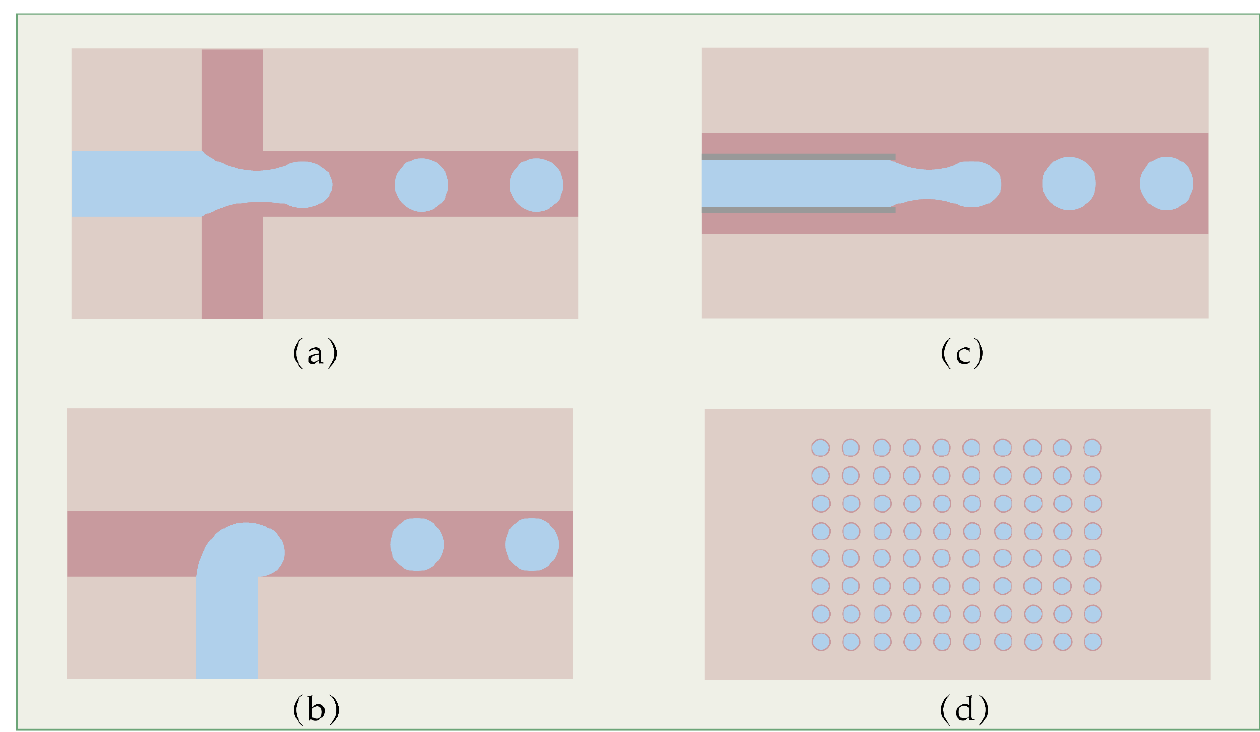
Figure 3. Basic structure of droplet and microwell microfluidic devices for scRNA-seq: ( a ) T-junction; ( b ) flow-focusing; ( c ) co-flow; ( d ) microwell.